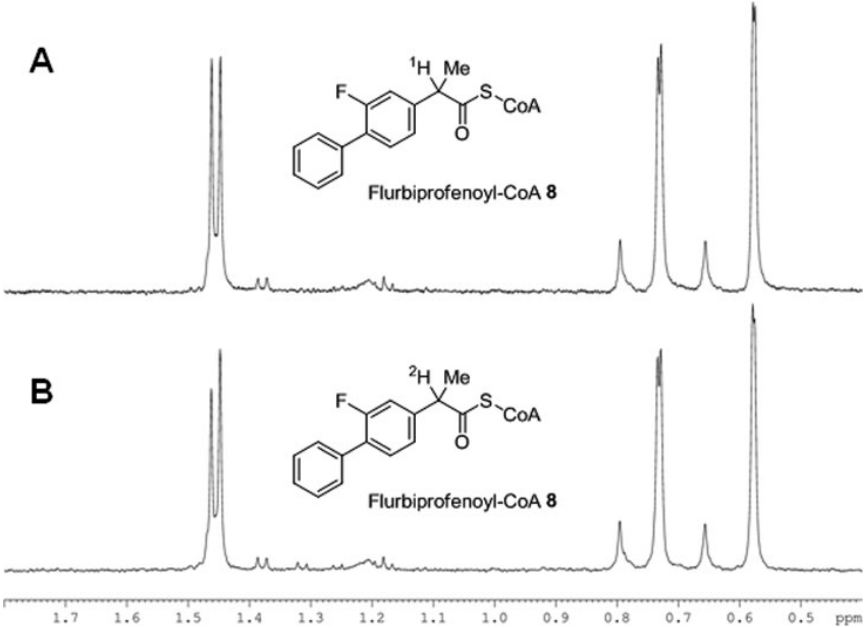
Figure 8. 2 H-Exchange of ±-flurbiprofenoyl-CoA ester under the action of AMACR that shows change in methyl group multiplet at d 1.45 ppm. (A) Heat-inactivated enzyme; (B) Active enzyme. Reproduced from [29] with permission from The Royal Society of Chemistry.